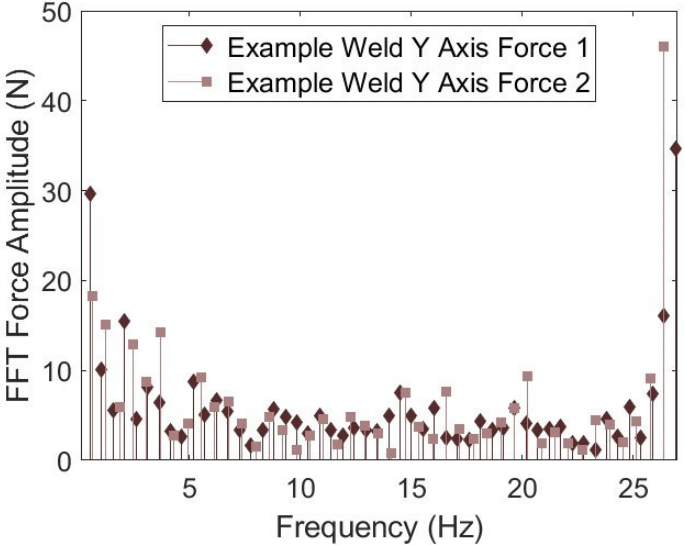
Figure 10. FFT amplitude plotted against the spectral band from 0 to 27 Hz from the “bad welds” from Figure 9.